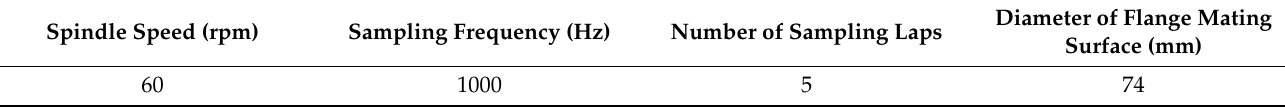
Figure 6. Diagram of the experimental setup. Table 1. Experimental parameters.